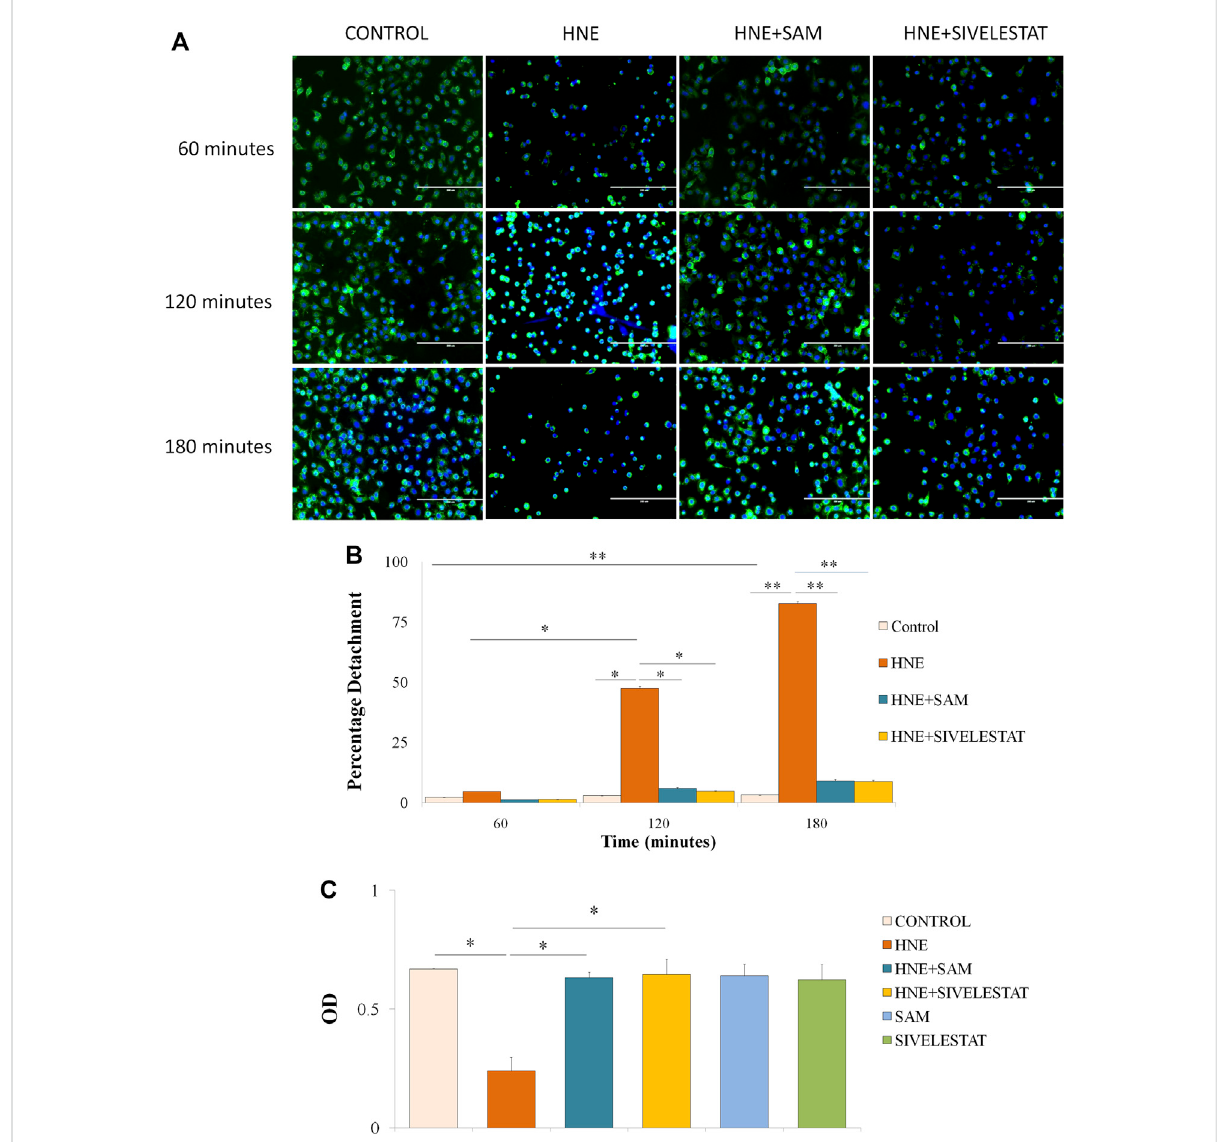
FIGURE 4 S. apetala fruit extract exerts inhibitory effect on elastase-induced human lung epithelial cells (A) A549 cells were treated with elastase. After 2 hours ofincubation, elastase triggered therounding ofA549 cells.The combinationofSAMorsivelestattherapyreducedtheimpactofelastase,as shown under a fl uorescence microscope at a 10× magni fi cation with WGA (green) staining the cell membrane and DAPI (blue) staining the nucleus. (B) Percentage cell detachmentfrom culture plate after treatmentwith elastase after every 1 hour. (C) MTT Assay was done to ascertain